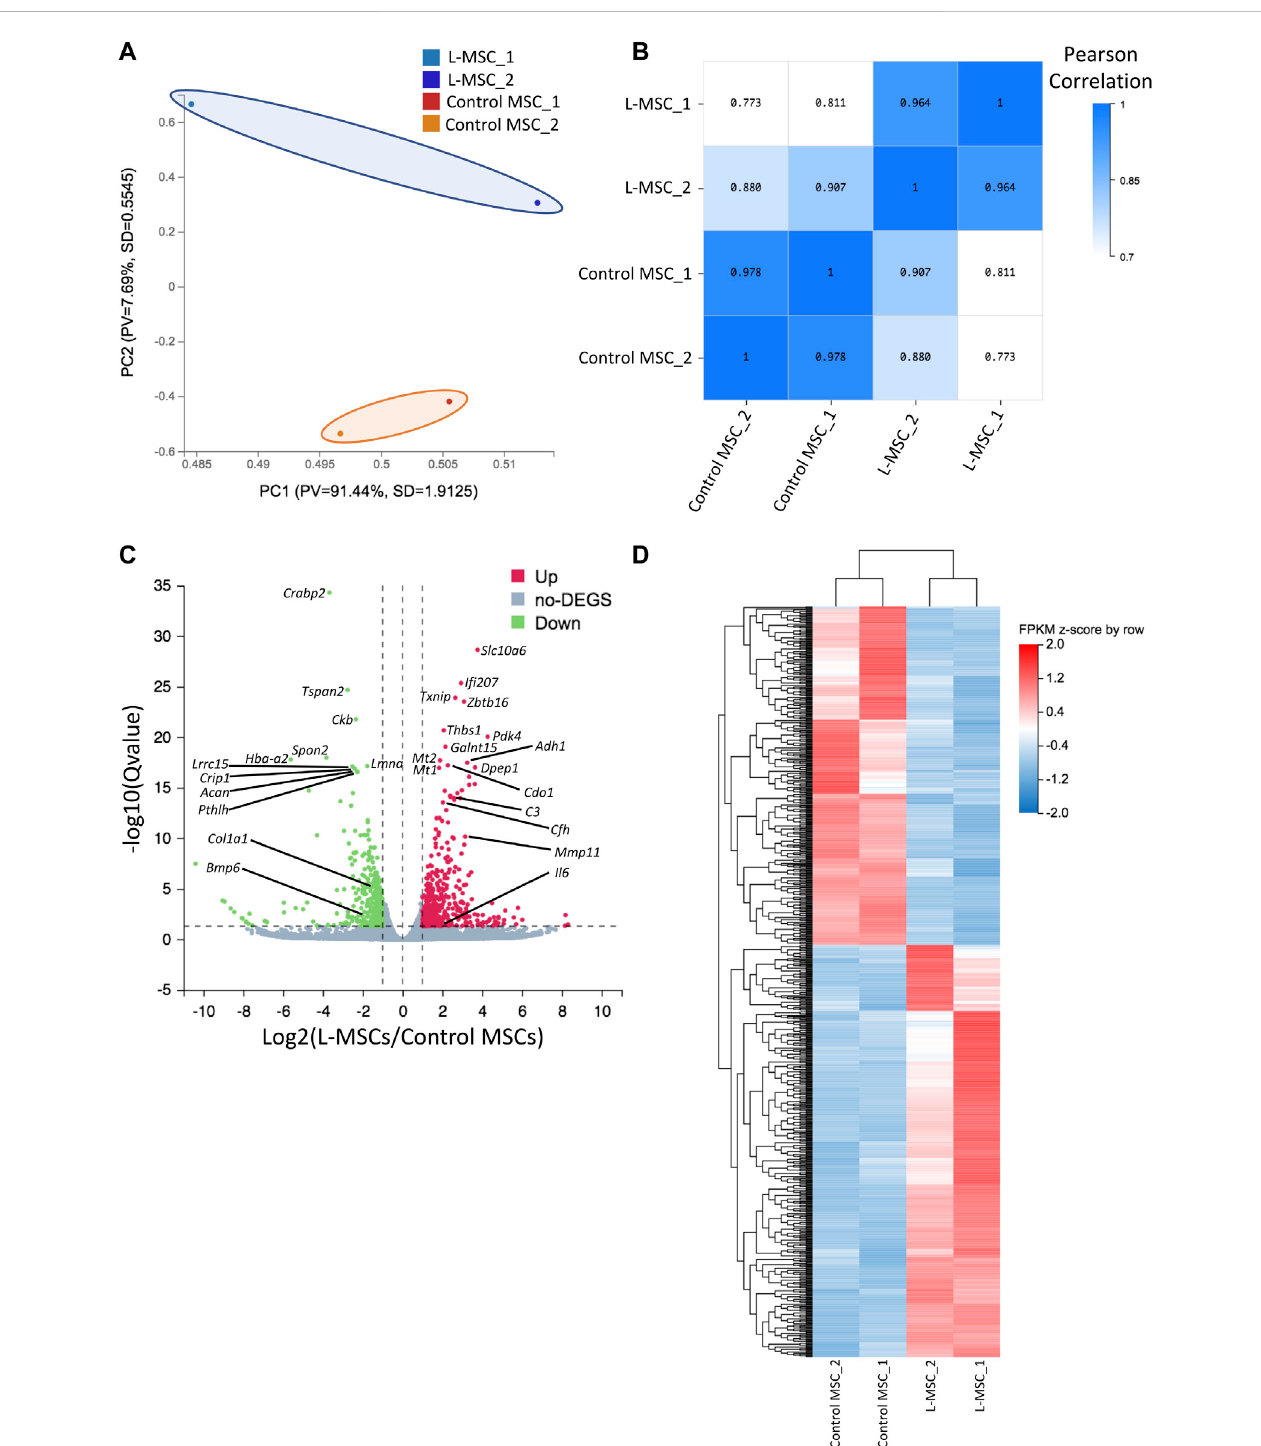
RNA sequencing reveals molecular changes in L-MSCs. (A) Principal component analysis based on row z-score of FPKM values for control and L-MSCs shows that the control and L-MSC group variable was separated by PC2 (n = 2, four to seven mice pooled per sample). (B) Sample correlation heatmap based on Pearson correlation coef fi cient identi fi ed that intergroupvariabilitywas greater than intragroup variability. (C) Volcano plotdemonstrating thepresence of 770 differentially expressed genes (DEGs) in L-MSCs compared to control MSCs (|Log2FC| ≥ 1, q-value ≤ 0.05). Green represents downregulated genes; red represents upregulated genes. (D) Unsupervised clustering of DEGs shown in the volcano plot. Heatmap is of FPKM values standardized by row z-score.